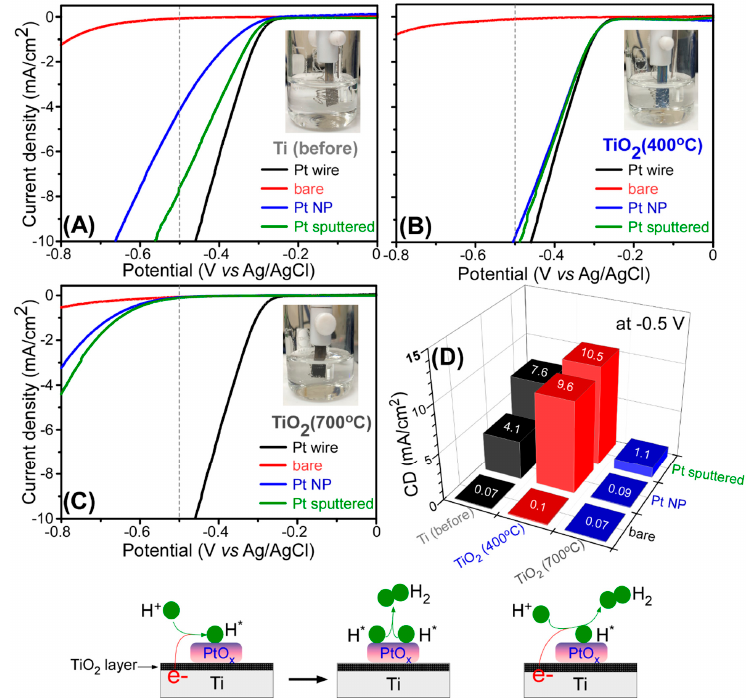
Figure 7. Linear sweep voltammetry (LSV) data at a scan rate of 10 mV / s for: ( A ) bare Ti, Ti (400 ◦ C) and Ti (700 ◦ C); ( B ) Pt NP / Ti, Pt NP / Ti (400 ◦ C) and Pt NP / Ti (700 ◦ C); ( C ) Pt-sp / Ti, Pt-sp / Ti (400 ◦ C) and Pt-sp / Ti (700 ◦ C) samples, and for Pt wire (blank line); ( D ) current density (mA / cm 2 ) taken at − 0.5 V for the corresponding samples. The HER mechanism is depicted